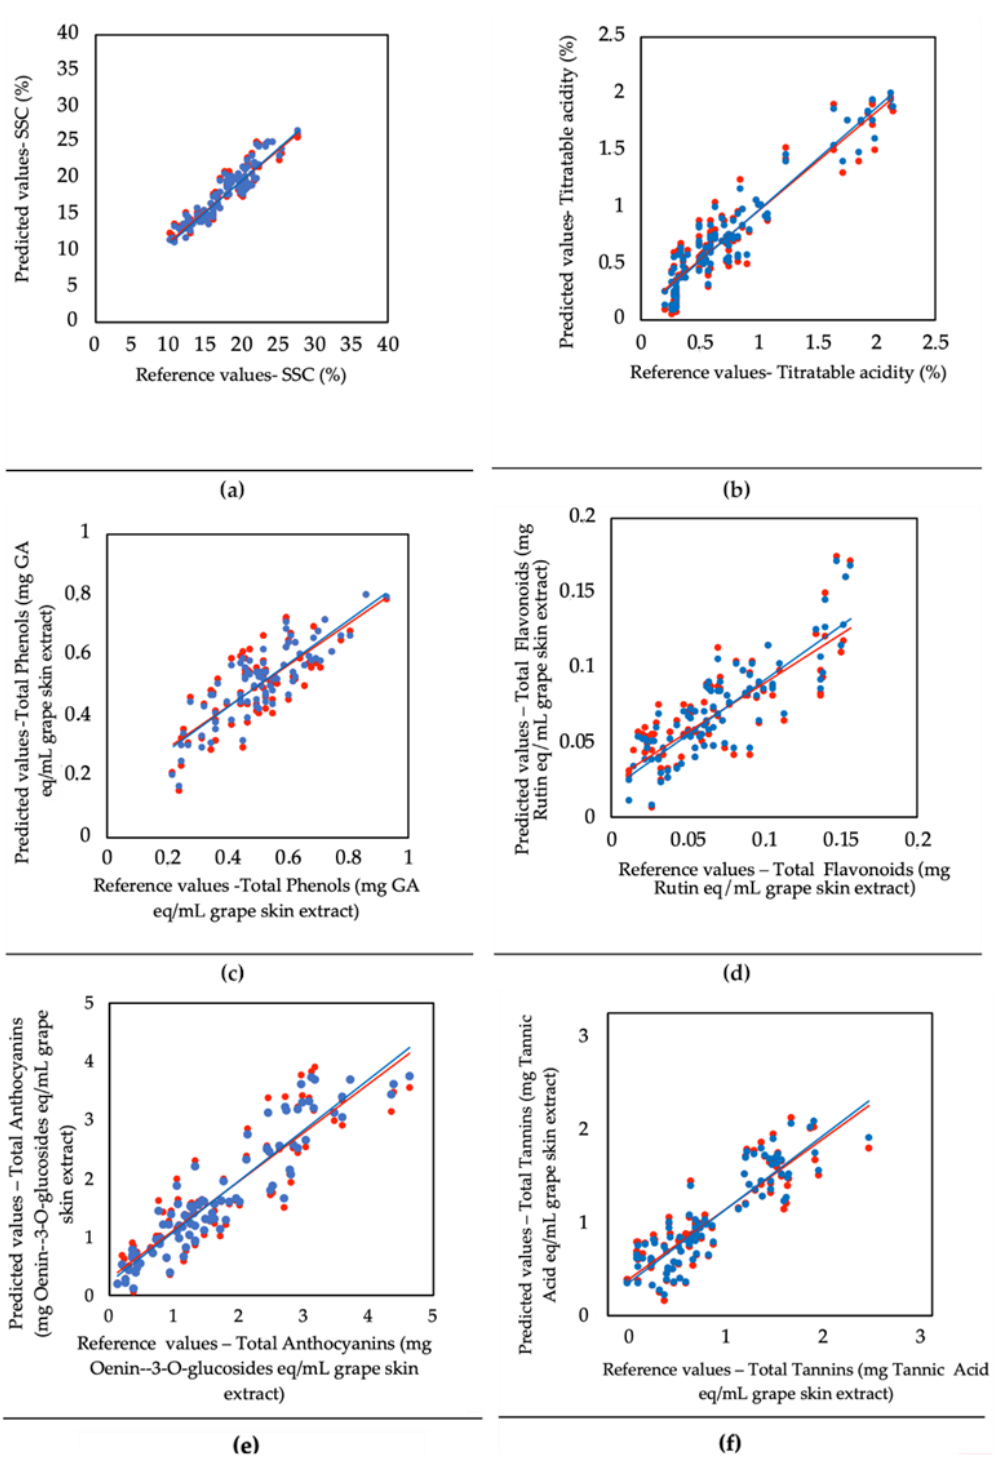
Figure 4. Plot of reference values vs. PLSR predicted values of calibration and cross validation sets for different compounds ( a )—Soluble solids content -SSC (%); ( b )—Titratable acidity (%); ( c )— Total phenolic content (mg GA eq/mL grape skin extract); ( d )—Total flavonoids content (mg Rutin eq/mL grape skin extract); ( e )—Total anthocyanins (mg Oenin–3-O-glucosides eq/mL grape skin extract); ( f )—Total of tannins (mg Tannic Acid eq/mL grape skin extract); Model developed with the calibration set; Model developed with the validation